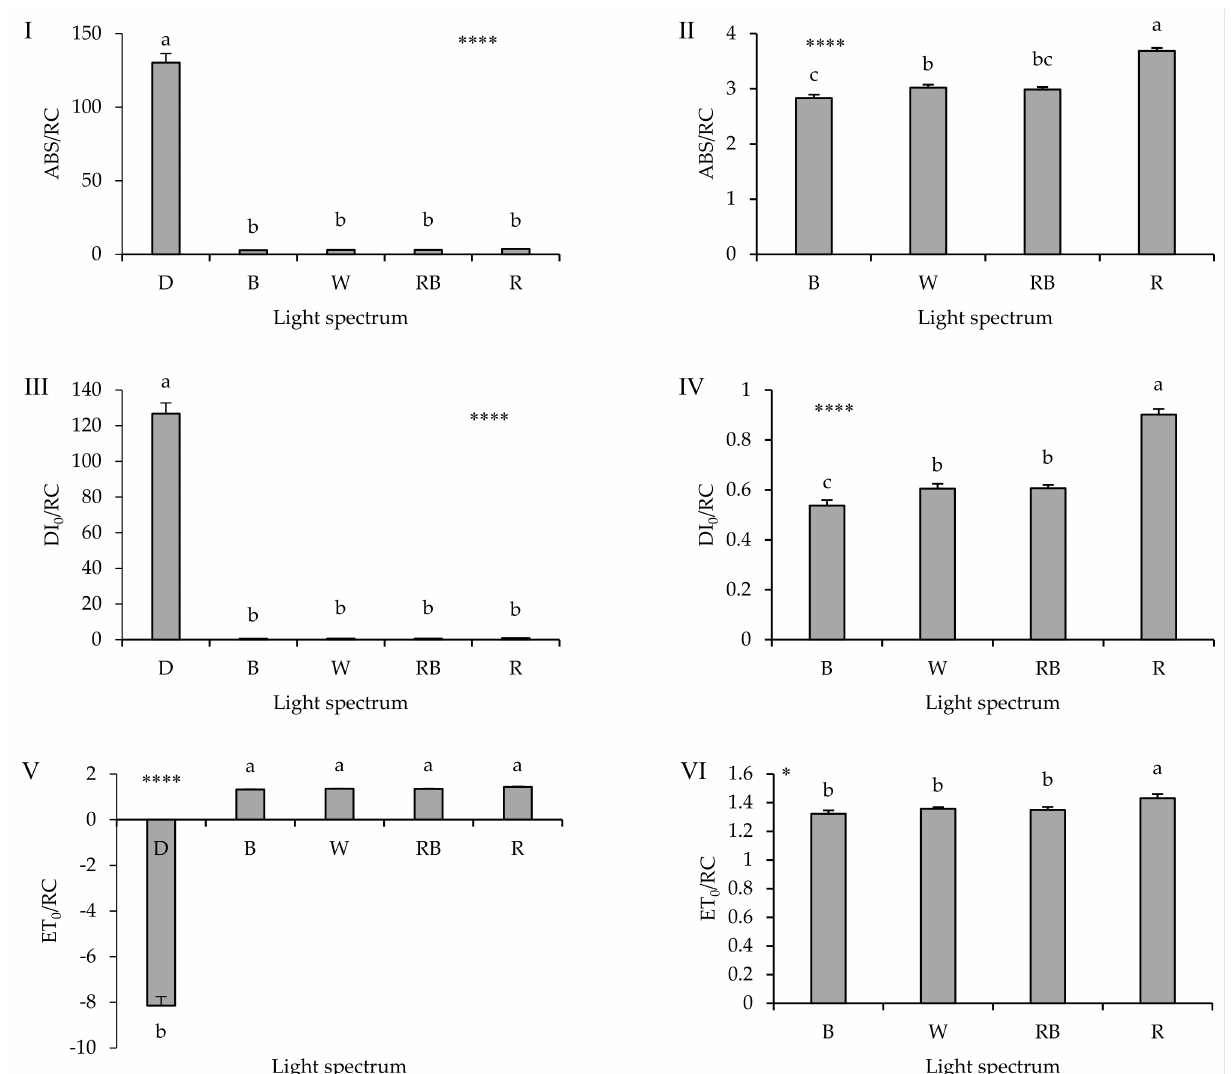
Figure 6. Specific energy fluxes per reaction center (RC) for energy absorption (ABS/RC; I , II ), dissipated energy flux (DI 0 /RC; III , IV ), electron transport flux (ET 0 /RC; V , VI ); equations and explanations in Table 2) from the fluorescence transient exhibited by leaves sampled from grafted watermelon seedlings exposed for 12 days to either darkness (D) or different light quality regimes [blue (B), white (W), red and blue (RB), as well as red (R); see spectrum in Supplementary Figure S3]. Photosynthetic photon flux density was 20 ± 1 µ mol m − 2 s − 1 during the first 2 days, and 50 ± 1 µ mol m − 2 s − 1 during the following days. The Panels II, IV, and VI (on the right) represent the same data as the Panels I, III, and V (on the left), besides the darkness treatment which was excluded. Nine plants per treatment were assessed. Different letters indicate that values are significantly different at p < 0.01 according to Duncan’s multiple range tests. Bars represent SEM. Significance at the 0.05, and 0.0001 probability levels is indicated by * and ****, respectively. TR 0 /RC was the highest in seedlings healed and acclimatized under D, followed by those exposed to R (Figure 7). No significant difference was noted in TR 0 /RC value between seedlings exposed to B, W, or RB